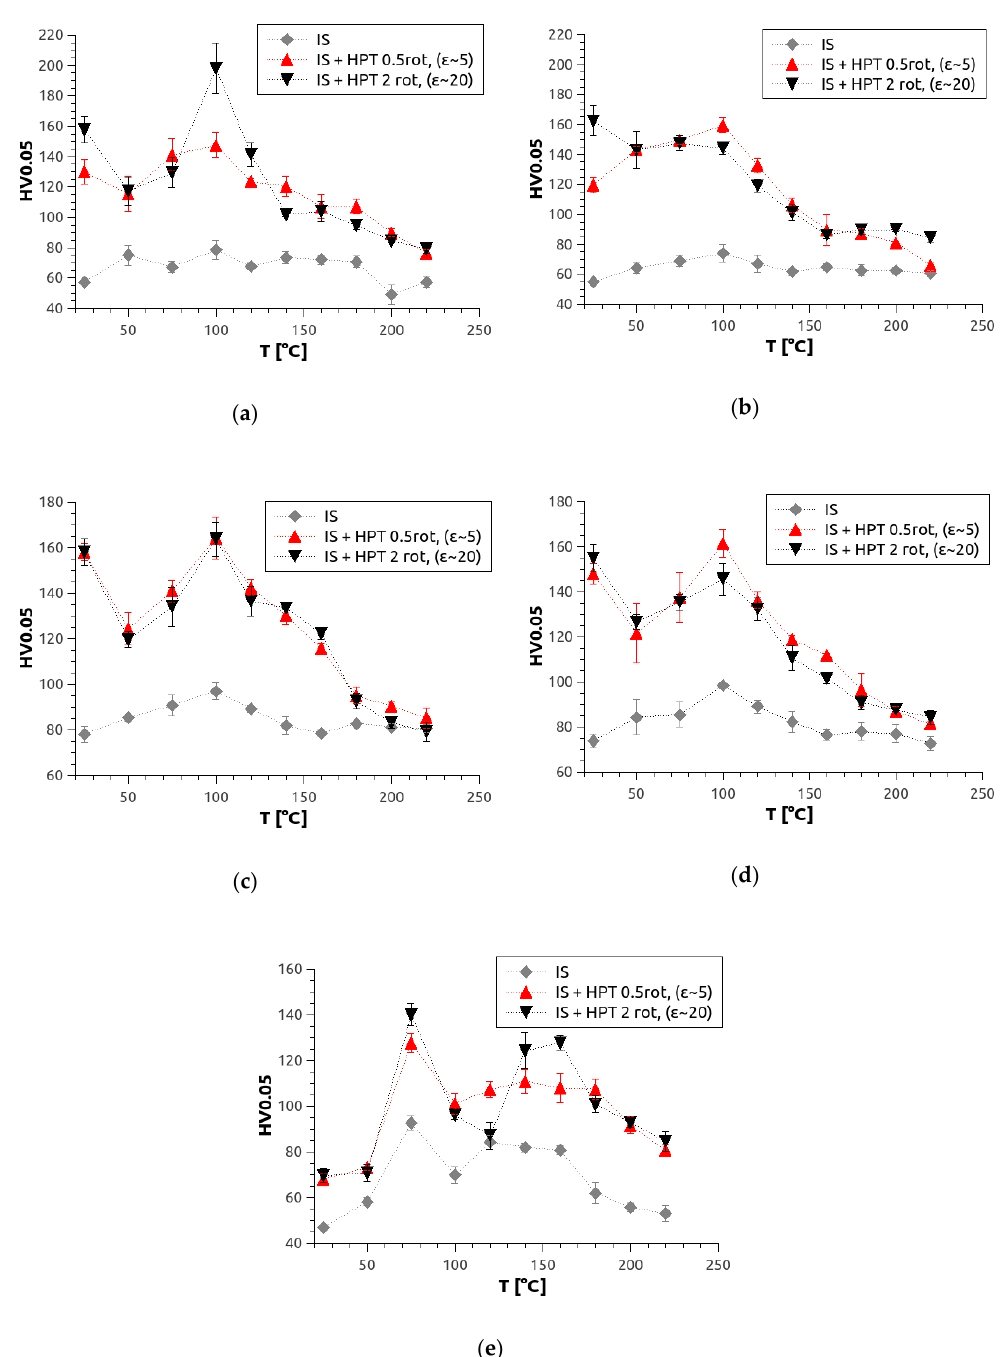
Figure 8. Microhardness after heat treatments for 1 h at various temperatures for ( a ) Mg5Zn0.3Ca ( b ) Mg5Zn ( c ) Mg5Zn0.5Ca ( d ) Mg5Zn0.15Ca0.15Zr and ( e ) Mg0.3Ca in the IS (furnace-cooled) (grey), at ε ~5 (red) and ε ~20